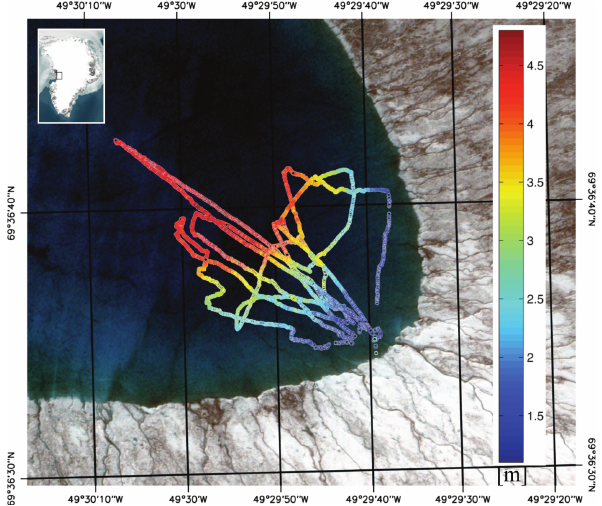
Fig. 2. Boat paths and measured depth values imposed over a high- resolution (0.5m) Wordlview-2 image.